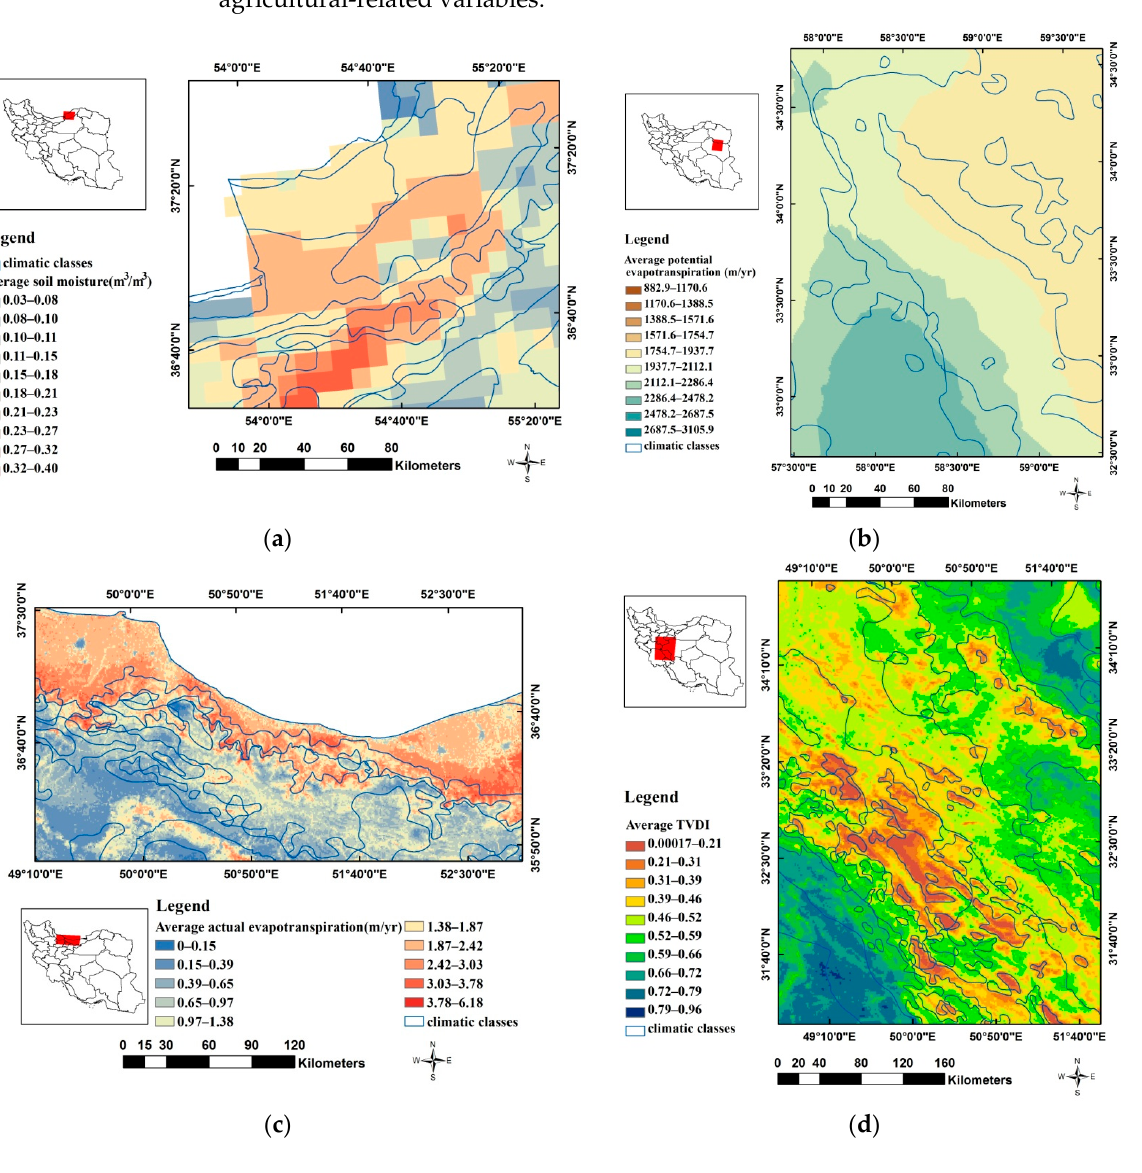
Figure A1. Visual comparison of the climate zones with four remotely sensed agricultural-related variables: average soil moisture ( a ), average potential evapotranspiration ( b ), average actual evapo- transpiration ( c ), and mean yearly TVDI ( d